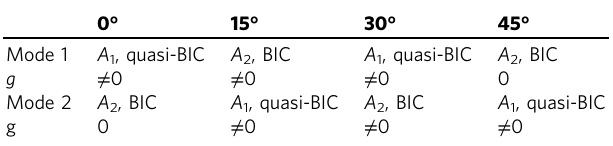
Table 1 Summary of mechanical mode representation and optomechanical